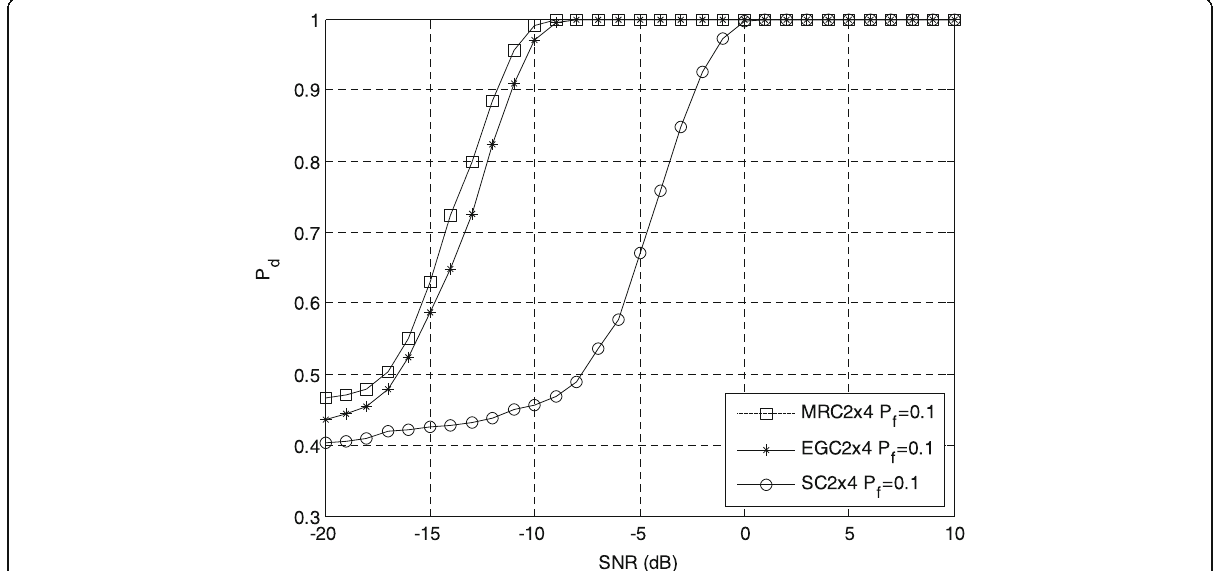
Fig. 7 Performance comparison of the three combining detection methods in 2 × 4 MIMO